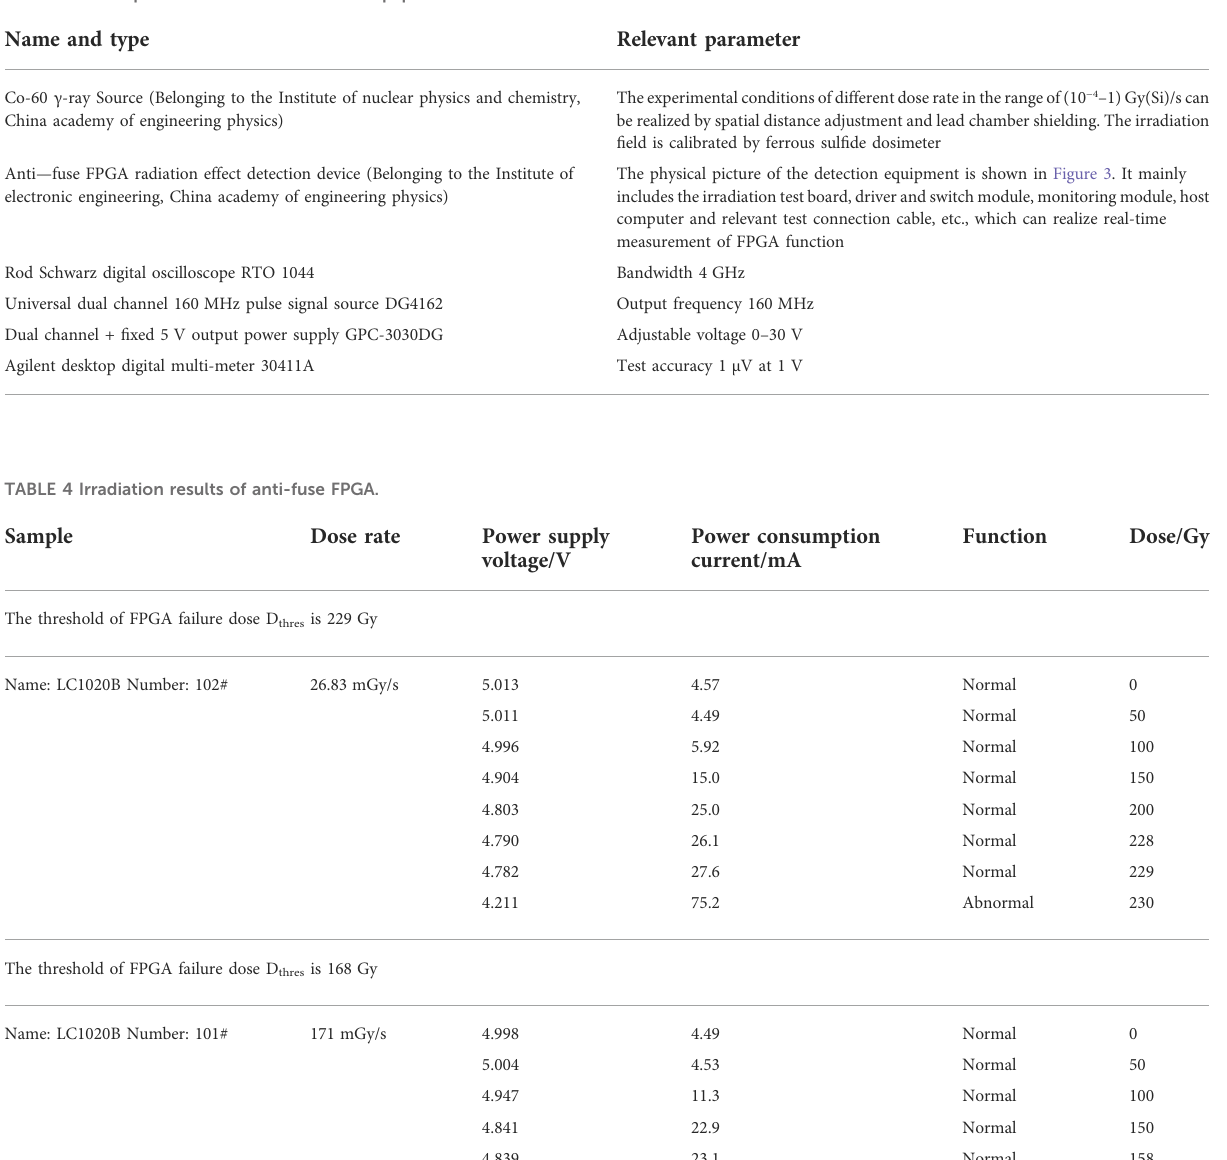
TABLE 3 The experimental instruments and equipment.